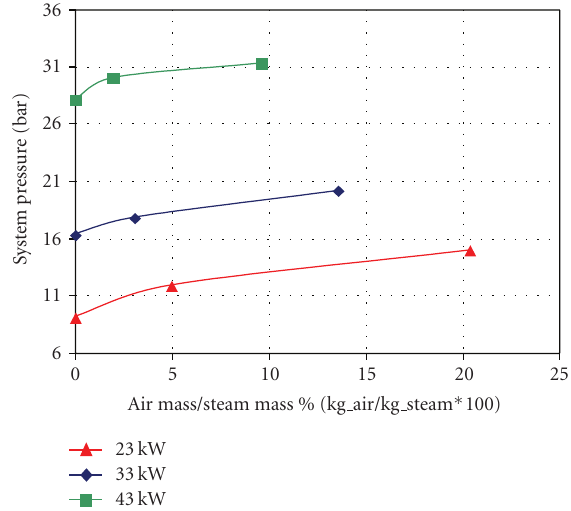
Figure 6: Noncondensable gas concentration e ff ect on system pressure